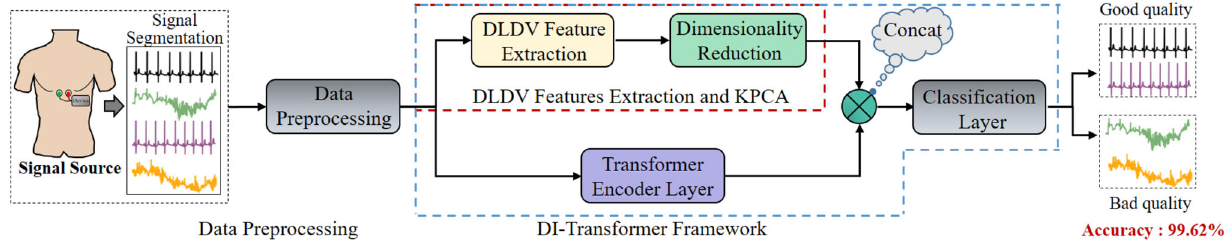
Fig. 1 The overall framework of the proposed SQA model. Note that this paper focuses on SQA of MA-contaminated long-term ECGs